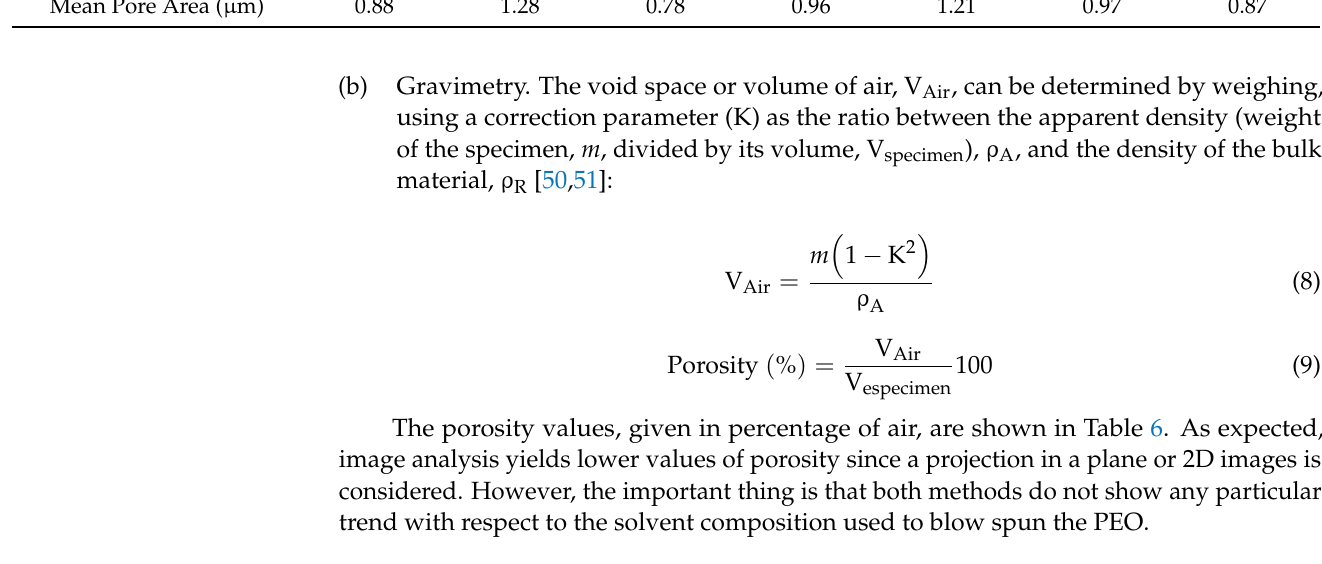
Table 6. Estimated porosities deduced from image analysis and